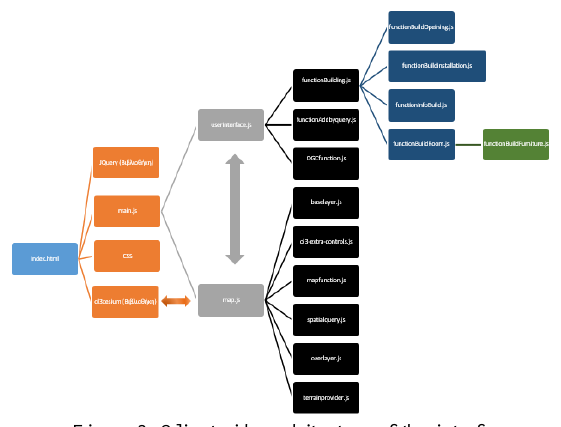
Figure 3: Client-side architecture of the